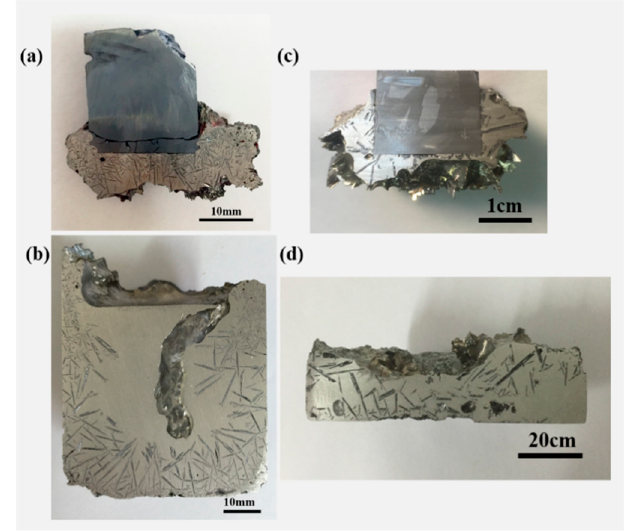
Figure 2. Cross section of the samples within di ff erent part: ( a ) pulled-up alloy (PUA) in Al–25%Si alloy; ( b ) remained alloy (RA) in Al–25%Si alloy; ( c ) PUA in Al–28%Si alloy; ( d ) RA in Al–28%Si